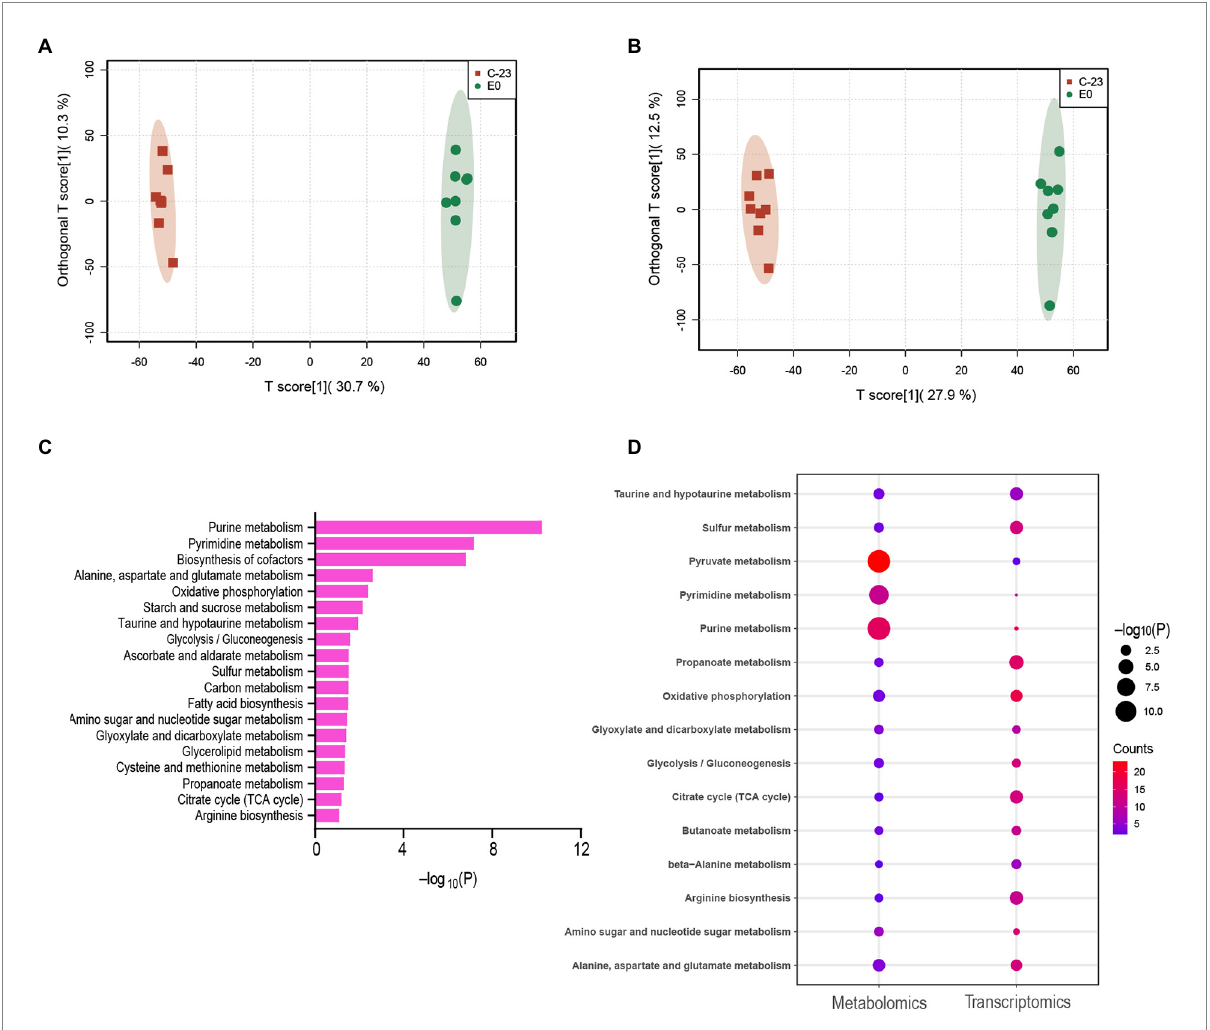
FIGURE 2 Comparative metabolomics profiles of 23-C-23 and 23-C-23: Δ EnvZ/OmpR . (A,B) Orthogonal partial least squares discriminant analysis (OPLS-DA) of positive and negative ionization dataset for the 23-C-23 and EnvZ/OmpR mutant strains. ( A : positive mode; B : negative mode), Each dot represents a biological replicate of each strain. Red square represents 23-C-23 , green dot represents 23-C-23: Δ EnvZ/OmpR . (C) KEGG pathway enrichment analysis of differential abundant metabolites. The y-axis represents KEGG terms, and the x-axis represents negative logarithm of value of p. (D) Metabolomics and transcriptomics share significant KEGG bubble charts. The size of the dots indicates the number of expressed genes or metabolites in the pathways, and the color of the dots represents the negative logarithm of value of p of the pathway.